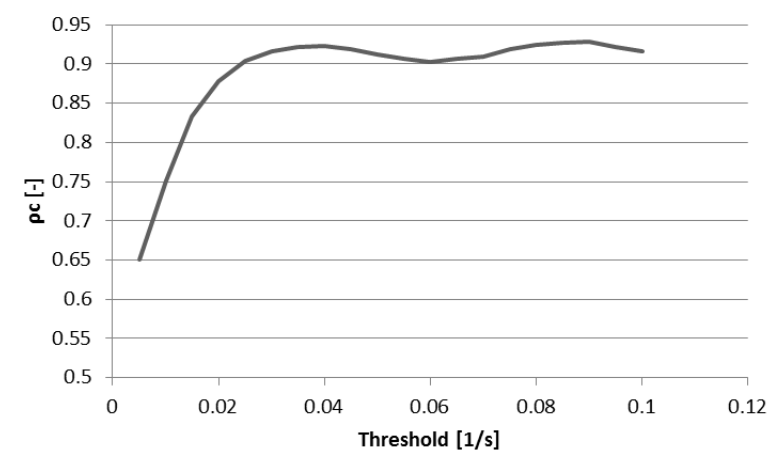
Figure 9. Concordance correlation coefficient of vorticity for two observers at multiple vorticity thresholds. Concordance increases with increasing vorticity threshold until a threshold of roughly 0.04 L/s. Bioengineering 2017 , 4 , 30 11 of 15